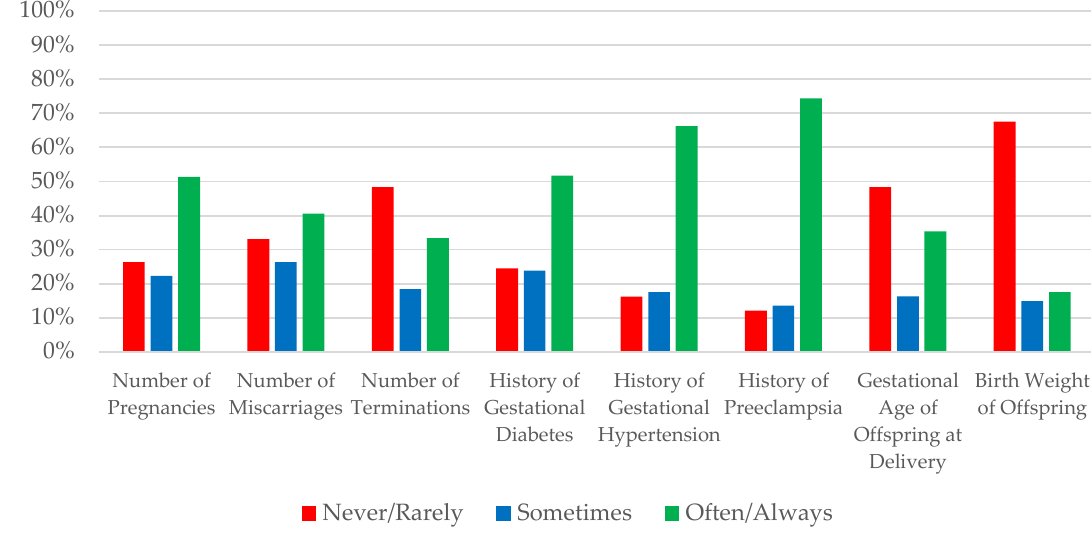
Figure 2. Frequency of obstetrical history documentation by survey respondents.